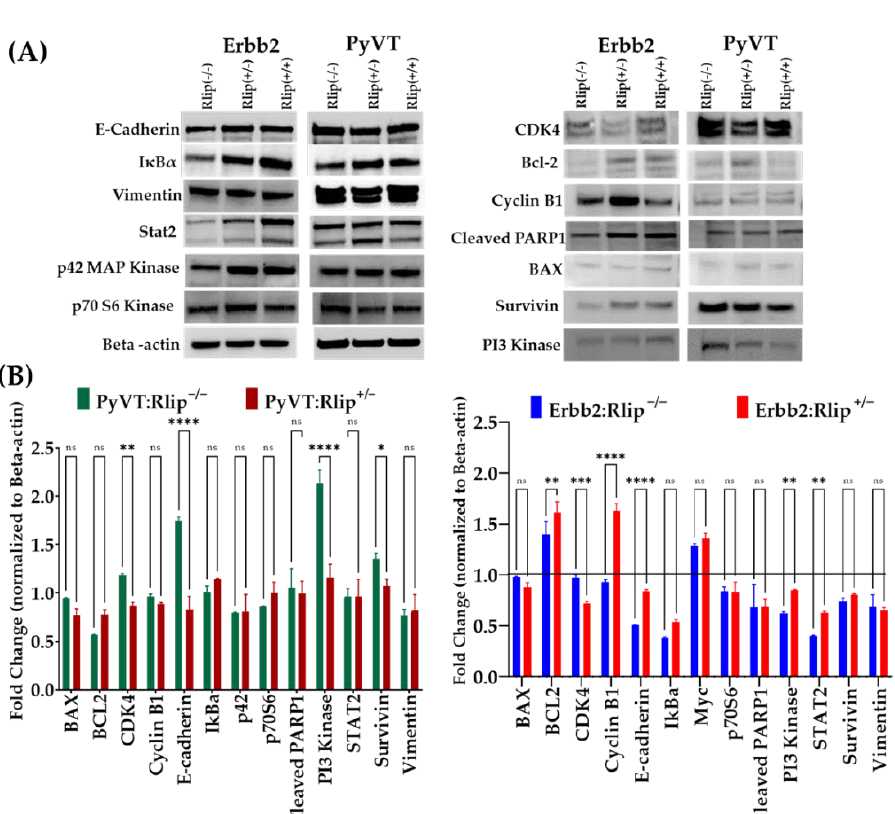
Figure 6. ( A ) Effect of genetic Rlip knockout on the levels of cell survival, proliferation, apoptosis, and differentiation marker proteins in PyVT and Erbb2 breast cancer tumors. Western blots showing apoptosis, cell survival, proliferation, and differentiation marker proteins in lysates of tumors collected at study endpoints from Erbb2:Rlip +/+ , Erbb2:Rlip − / − , Erbb2:Rlip +/− , PyVT:Rlip +/+ , PyVT:Rlip − / − , and PyVT:Rlip +/ − mice. Representative Western blots are shown in the figure ( n = 3 tumors from each genotype). β -actin was used as a loading control. Detailed information about Western Blots can be found in the supplementary materials. ( B ) Effects of Rlip depletion on protein expression of markers of intracellular signaling in PyVT and Erbb2 mammary tumors. Western blot densitometry of tumor tissue lysates from PyVT:Rlip +/+ , PyVT:Rlip +/ − , PyVT:Rlip − / − , Erbb2:Rlip +/+ , Erbb2:Rlip +/ − , and Erbb2:Rlip − / − mice. The bar diagrams represent the fold change in protein levels in Rlip knockout genotypes (Rlip +/ − and Rlip − / − ) as compared to Rlip +/+ genotypes (defined as = 1, indicated by the solid line). Values are shown as mean +/ − SD ( n = 3 tumors from each genotype; ns = not significant, * = p < 0.01; ** = p < 0.005; *** = p < 0.001 and **** = p < 0.0001). β -actin was used as a loading control.